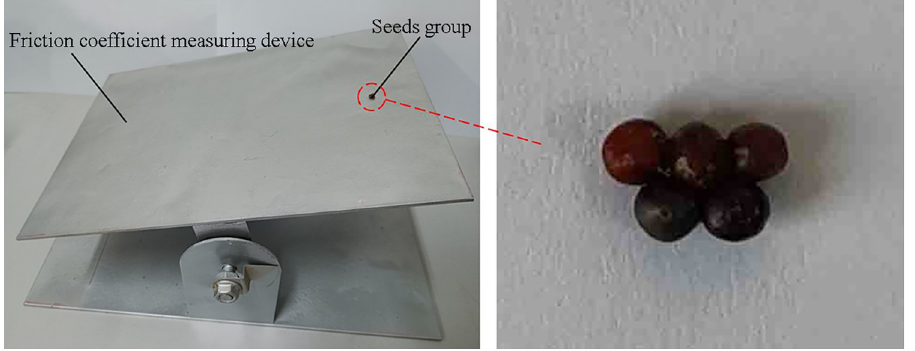
Fig 3. Determination of friction coefficient of Chinese cabbage